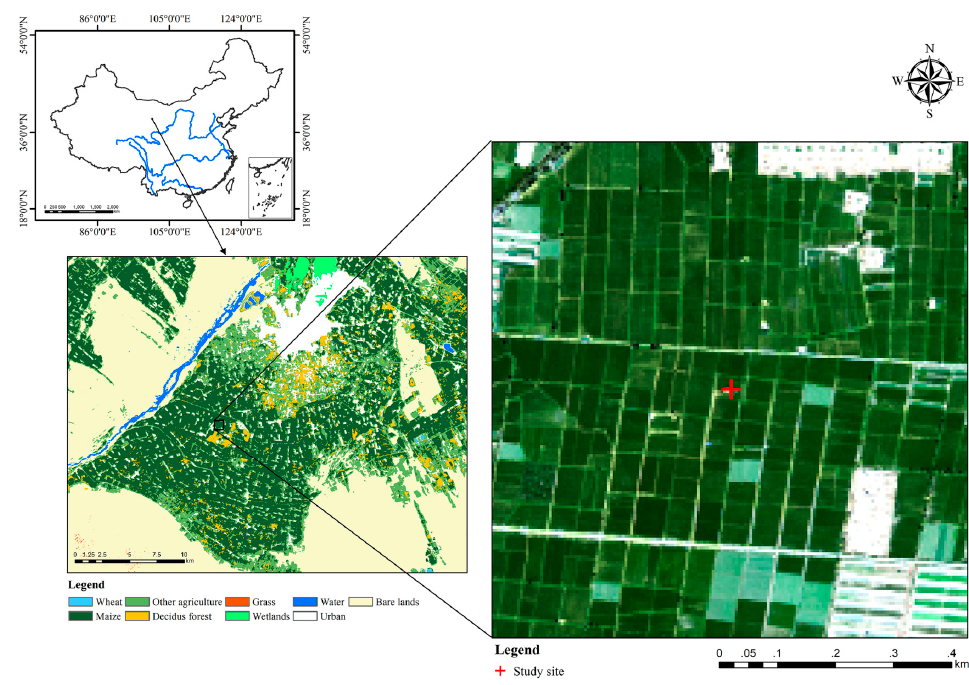
Figure 1. Location of the study site.